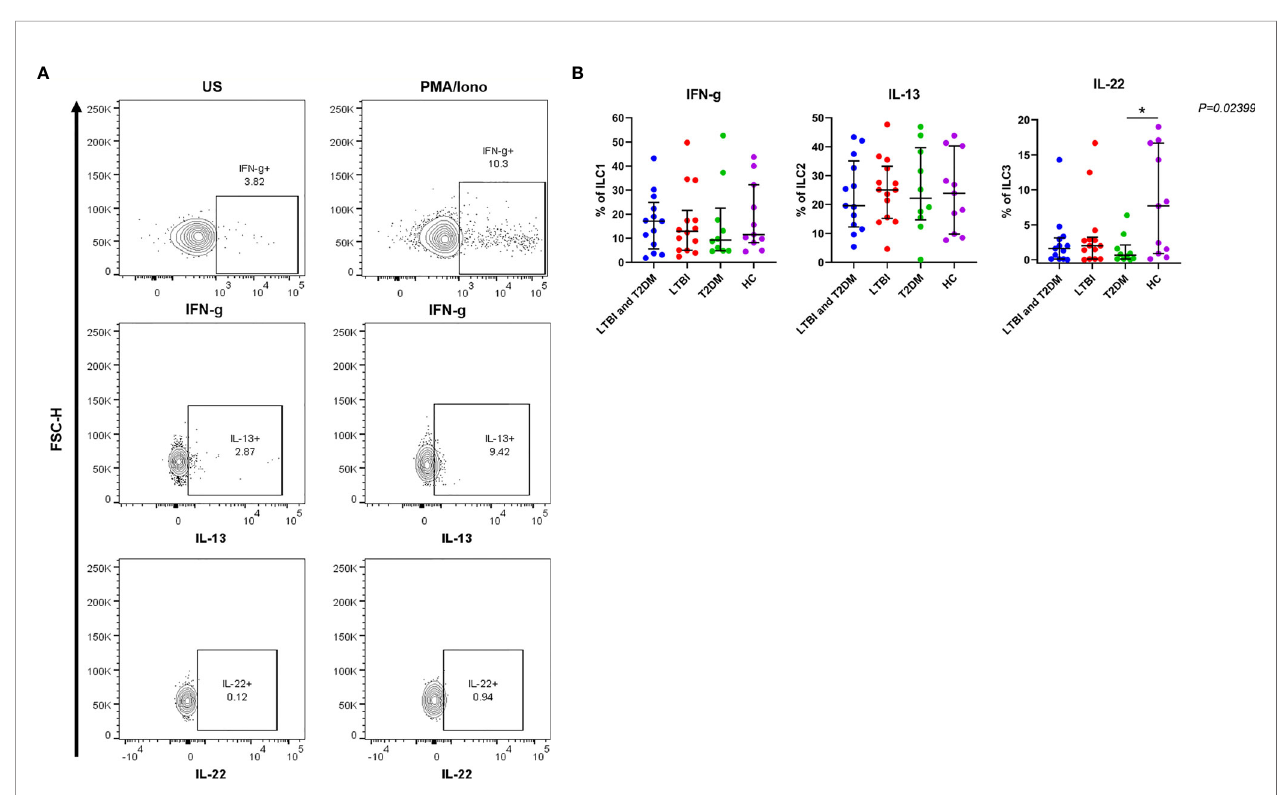
FIGURE 3 | For the production of IFN- g , IL-13, and IL-22; PBMCs were stimulated and cultured for 6 hours with PMA/ionomycin or unstimulated (US) plus Brefeldin A and stained intracellularly for cytokines. (A) Representative fl ow cytometry plots showing the production of IFN- g , IL-13 and IL-22 in response to R10 media (unstimulated) and PMA/ionomycin. (B) Percentage of ILC1, ILC2 and ILC3 cells expressing IFN- g , IL-13 and IL-22 respectively. Data represent medians and interquartile ranges. The non-parametric Kruskal-Wallis and Mann-Whitney U tests were performed to determine the statistical signi fi cance between the medians. Differences were considered statistically signi fi cant at P < 0.05 and 95% con fi dence level. Non-signi fi cant P-values were not shown. Size of groups: LTBI and T2DM (n = 13), LTBI (n = 14), T2DM (N=10), and HC (n = 11) *P-value < 0.05.